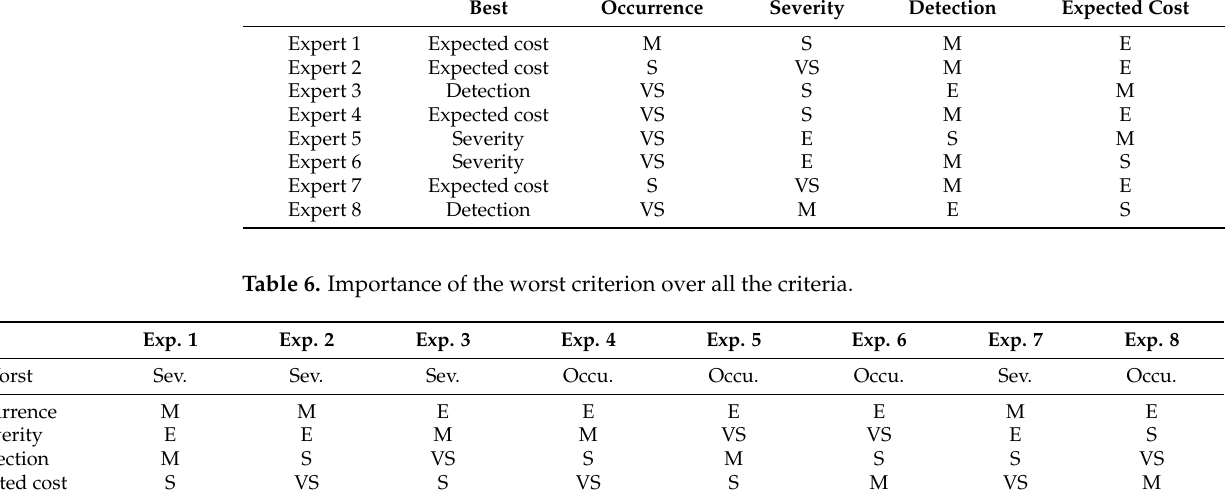
Table 7. The results of the interval weights are shown as follows: